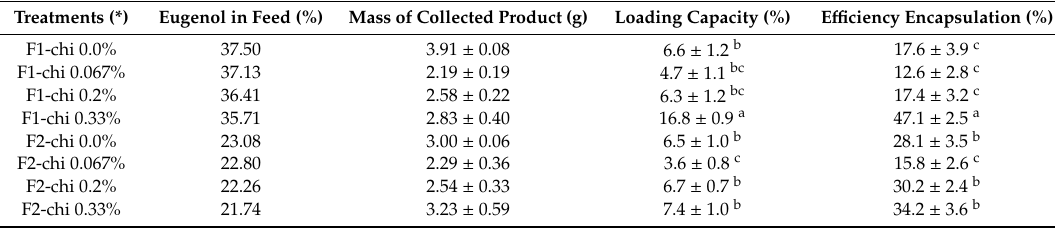
Table 4. Eugenol feed and encapsulation